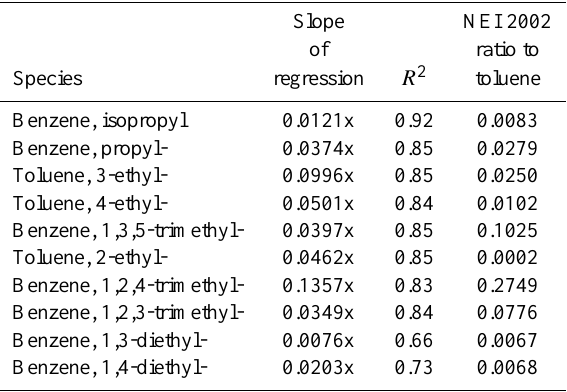
Table 3. The scaling factors for the 10 additional aromatic species against toluene along with their corresponding R 2 values from the linear regressions in Fig. 6. The 2002 NEI ratio to toluene for com-